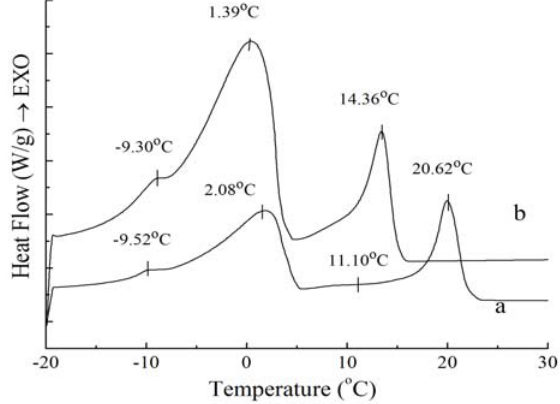
Figure 1. Crystallization curves of PS ( a ) and PO ( b ).